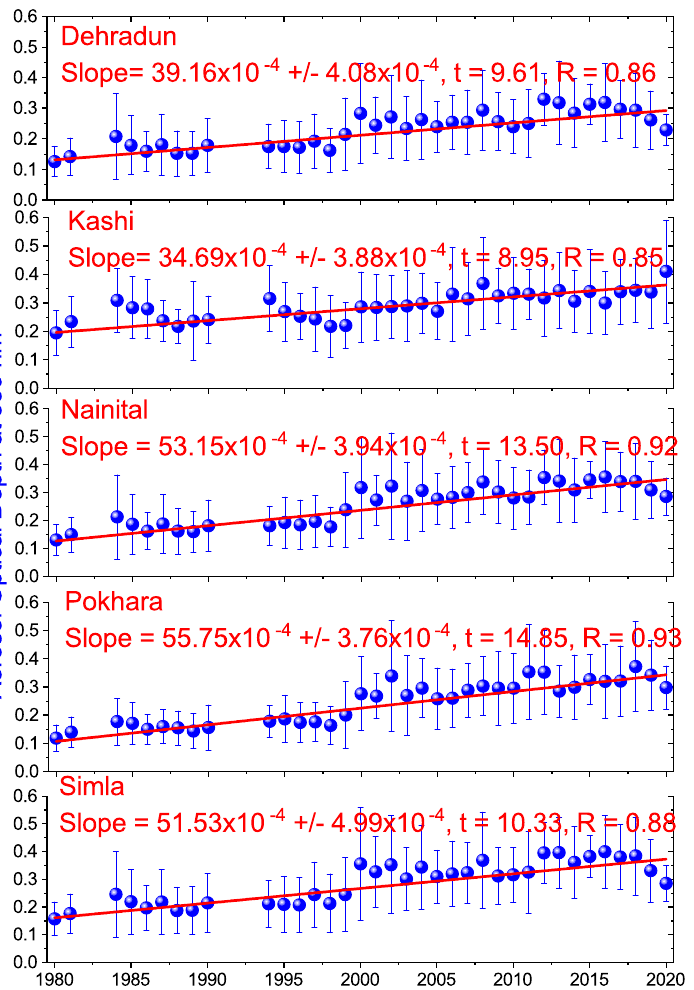
Figure 3. Yearly AOD trends at selected sites, which have significant increase in AOD values in the HKH region using monthly MERRA-2 data during